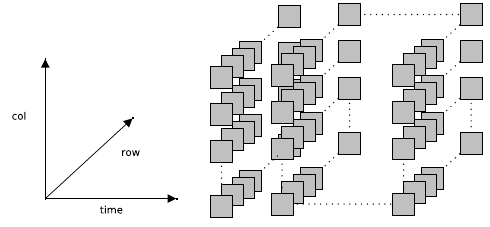
Figure 8. Observation rasters stored in a single 3-D tensor Cell values can be either positive or negative, integer, or floating point. At the same time, Many of the cell combinations might not make sense or the data for them might be missing. Cells have a NoData value to represent the absence of data (Figure 4). For example, building footprint raster dataset or land cover dataset are sparse in nature. Figure 9 shows the sparse represen-